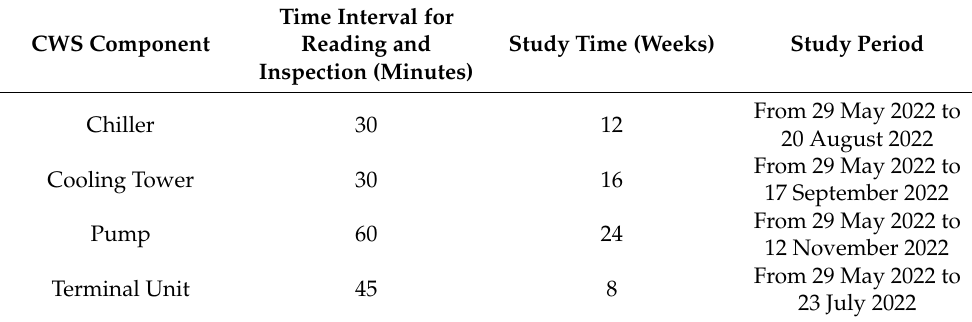
Table 6. Data Collection Plan.